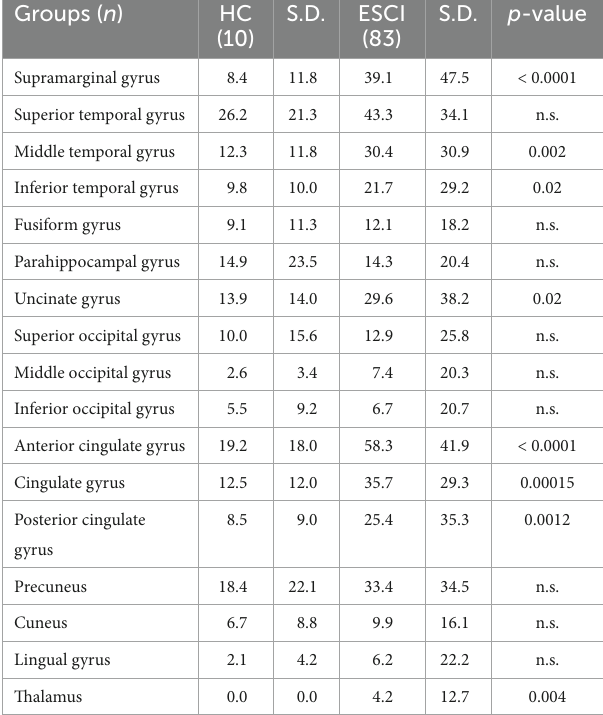
TABLE 1 General white matter lesion and dementia risk factors and MRI and SPECT analysis data in early-stage cognitive